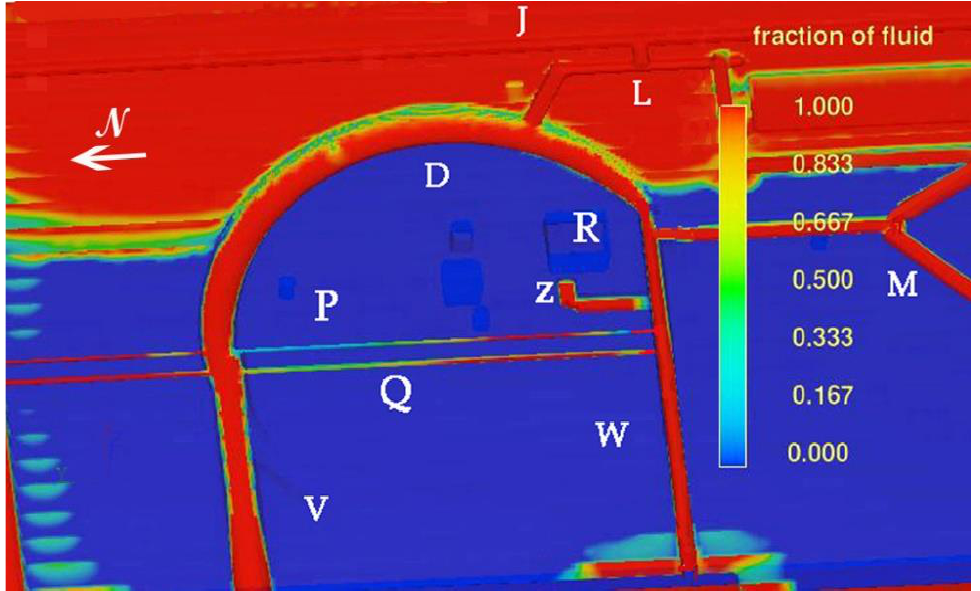
Figure 51. Dry season fluid fraction results shown at the depth of subterranean channels P and Q; from [2], p.